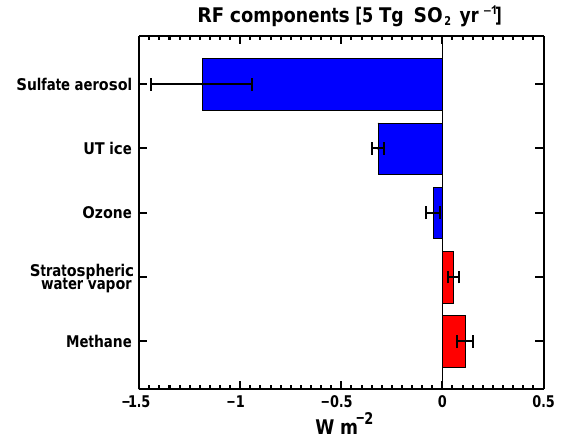
Figure 4. Summary of direct and indirect SG TOA RF per compo- nent (see Sects. 2.1 and 2.2) (global mean